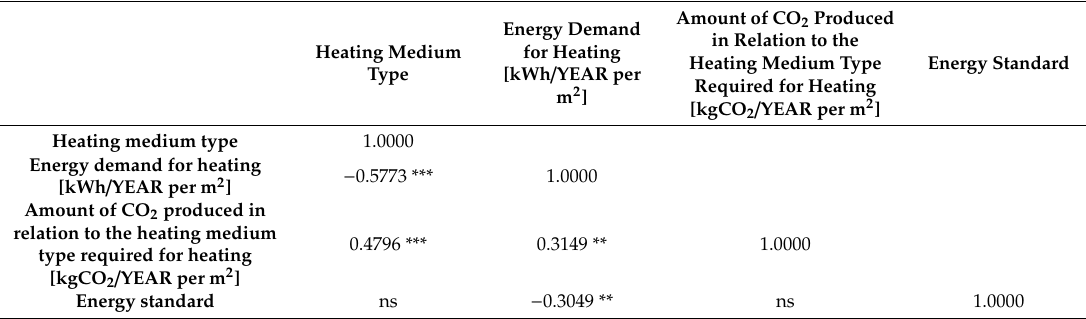
Table 1. Correlation analysis of selected parameters regardless of the construction type of the constructions.